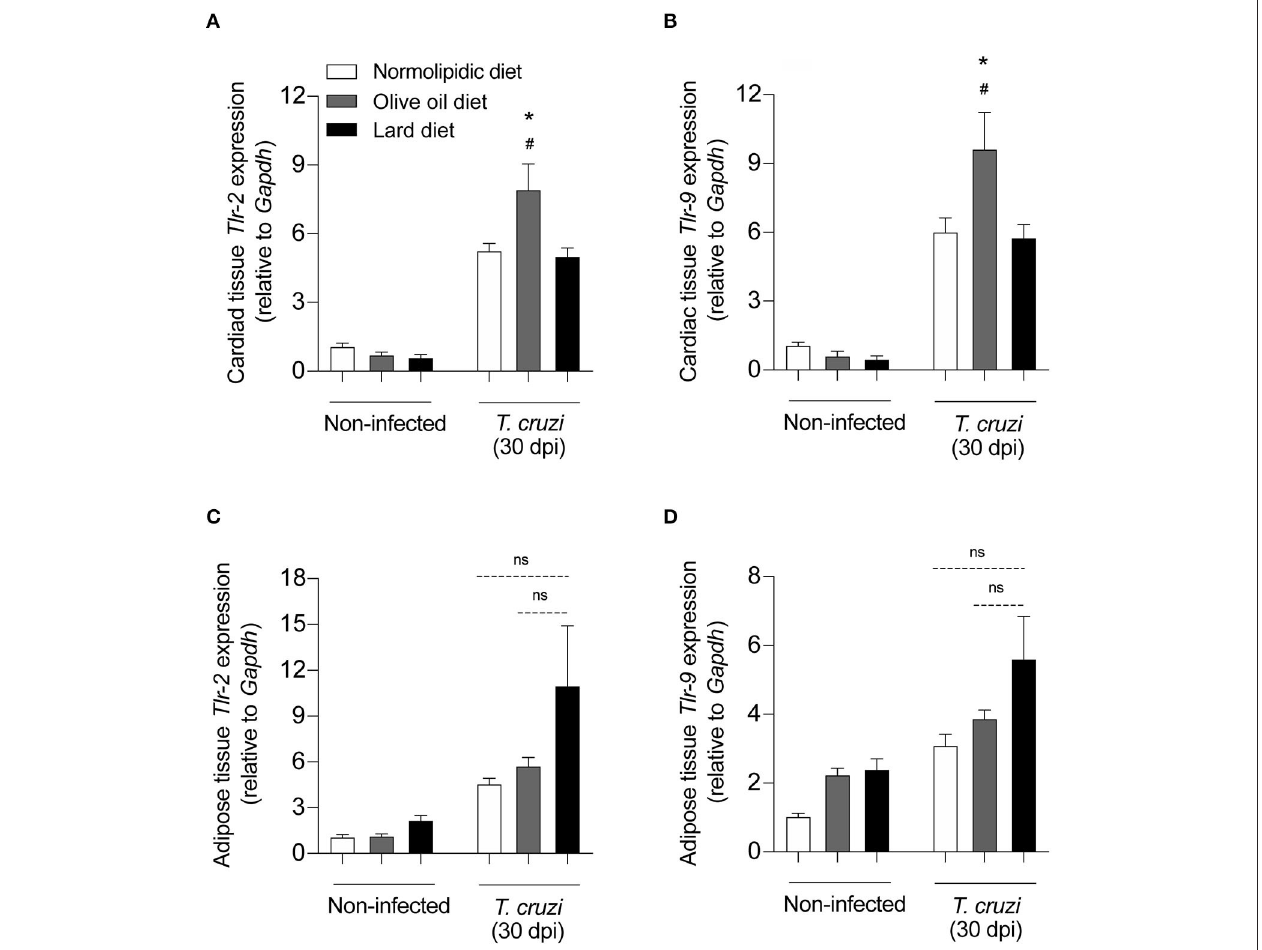
FIGURE 5 | TLRs expression on the heart and adipose tissue from T. cruzi infected mice fed with different types of hyperlipidic diets. Newly weaned C57BL/6 mice were fed with either a normolipidic diet ( n = 5), monounsaturated fatty acid diet with olive oil ( n = 5) or saturated fatty acid diet with lard ( n = 5). At the day 60 of diet, mice were intraperitoneally infected with 50 blood trypomastigote forms of T. cruzi Colombian strain. After 30 dpi the mRNA expression levels of Tlr2 and Tlr9 were measured in the heart (A,B) and adipose tissue (C,D) by real time quantitative PCR. Gapdh and 18S were used as housekeeping genes for the heart and adipose tissues, respectively. ns, not statistically different. # p < 0.05 compared with the non-infected group and * p < 0.05 compared with infected group by one-way ANOVA followed by Tukey post-hoc